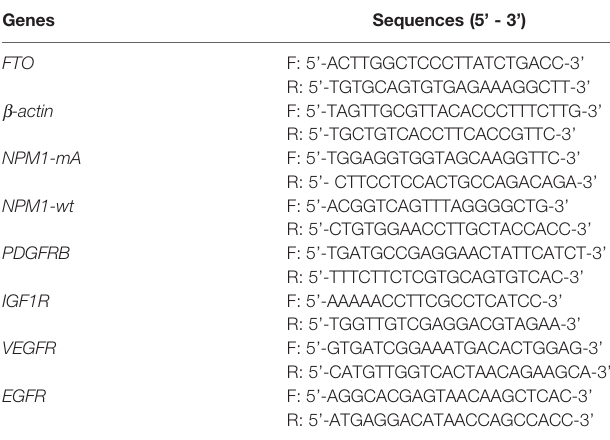
TABLE 2 | The PCR primer sequences for each gene used in this